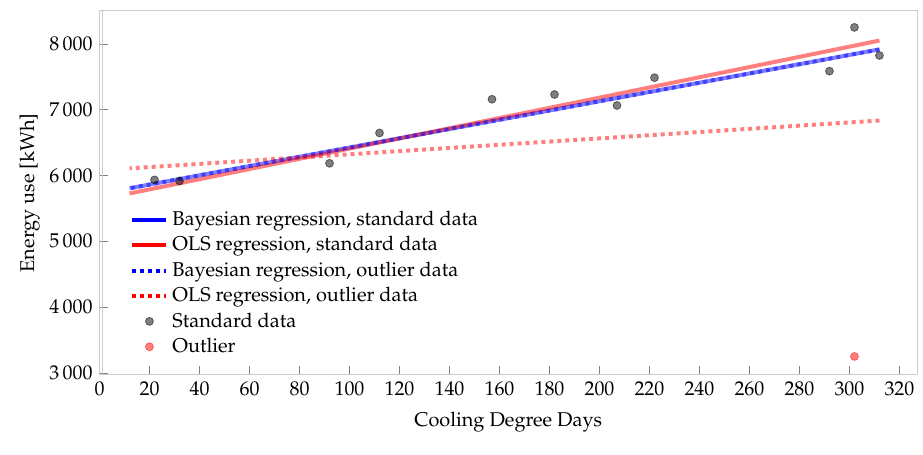
Figure 6. Demonstration of robustness of t -distributed Bayesian regression. Note that the two Bayesian regression lines (solid and dashed) coincide almost